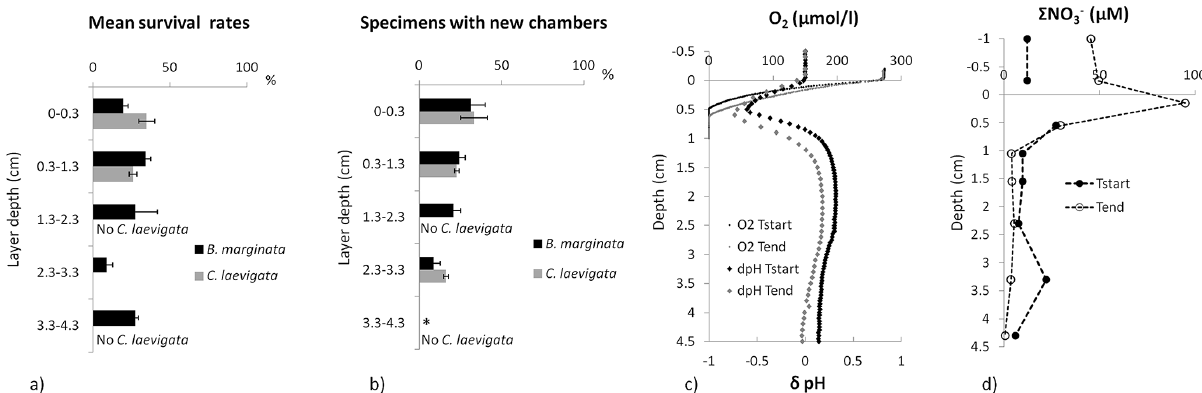
Figure 5. Main results of experiment 2 with Bulimina marginata and Cassidulina laevigata . (a) Mean survival rates; (b) specimens that calcified new chambers; (c) oxygen and δ pH profiles; (d) nitrate profiles. δ pH is calculated as the difference between measured values at various sediment depths and the pH value measured in overlying water. Error bars represent the mean standard error. In the 1.3–2.3 and 3.3–4.3cm layers, Cassidulina laevigata were not introduced (no Cassidulina laevigata ). Star ( ∗ ) indicates a significant p value for Tukey’s post hoc test ( <